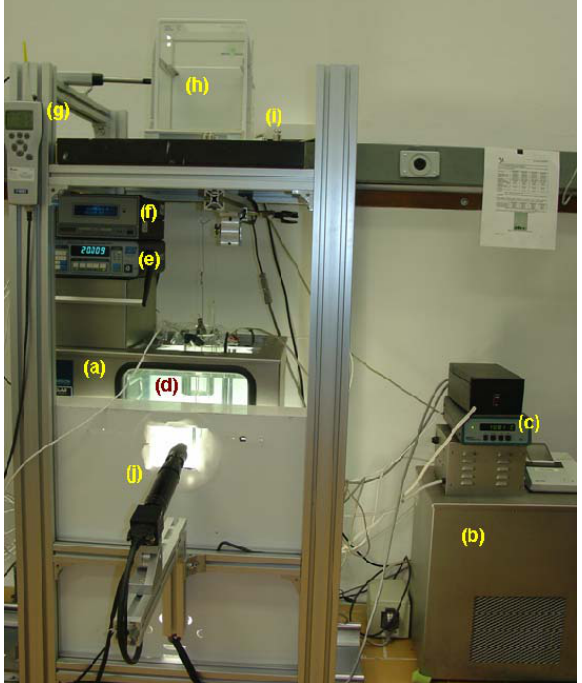
Figure 1. Hydrometer Calibration System: ( a ) thermostatic bath; ( b ) external cooler; ( c ) external temperature controller; ( d ) glass vessel containing the reference liquid; ( e ) thermometer for measuring the liquid temperature; ( f ) barometer; ( g ) thermo-hygrometer; ( h ) weighing instrument (balance); ( i ) mass